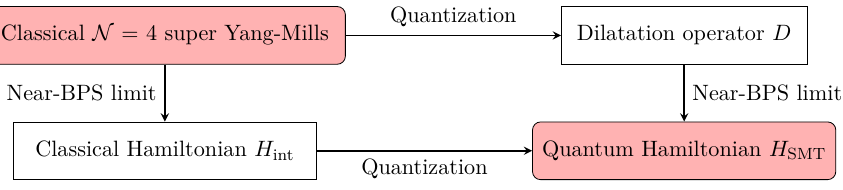
Figure 2 . Commutative diagram describing the two procedures to get a SMT Hamiltonian in a given near-BPS limit. One can either compute one-loop corrections to the dilatation operator and then restrict to a certain limit (right-down), or perform the sphere reduction and give a recipe to quantize the theory